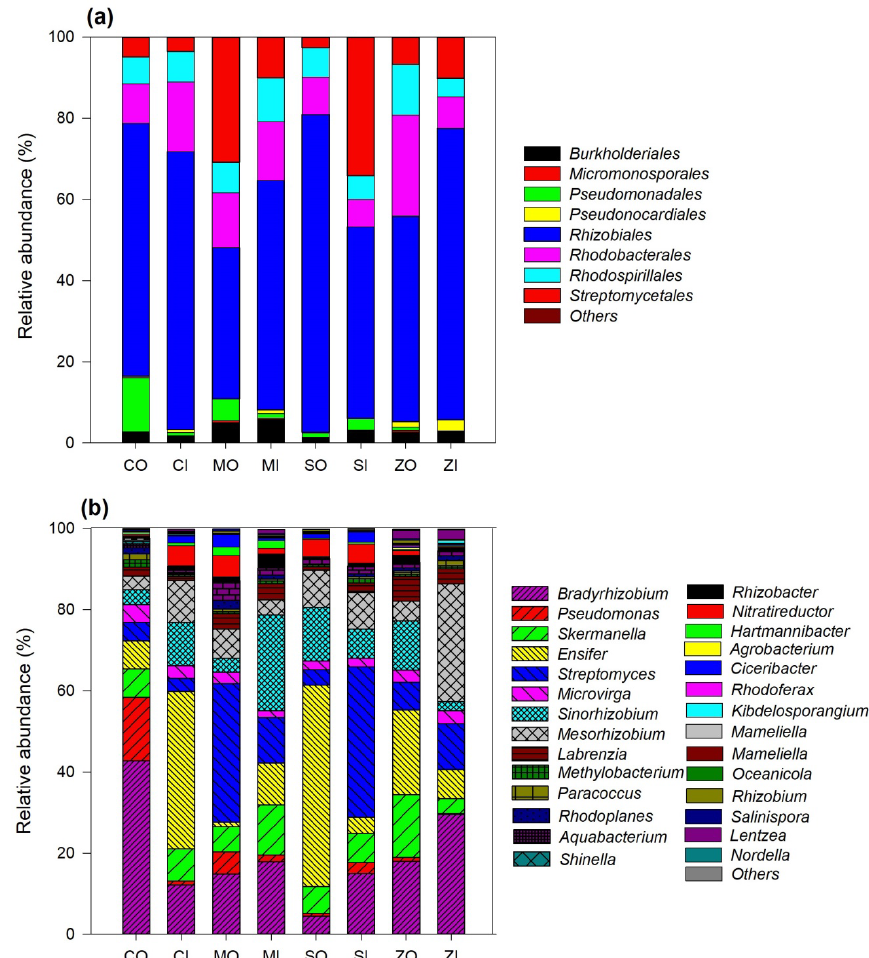
Figure 4. ( a ) Relative abundance of phoD -harboring bacterial communities under organic and con- ventional farming practices and different crops at the order level. ( b ) Relative abundance of phoD - harboring bacterial communities under organic and conventional farming practices and different crops at the genera level. CO, chickpea organic farming; CI, chickpea conventional farming; MO, mustard organic farming; MI, mustard conventional farming; SO, soybean organic farming; SI, soybean conventional farming; ZO, maize organic farming; ZI, maize conventional farming.